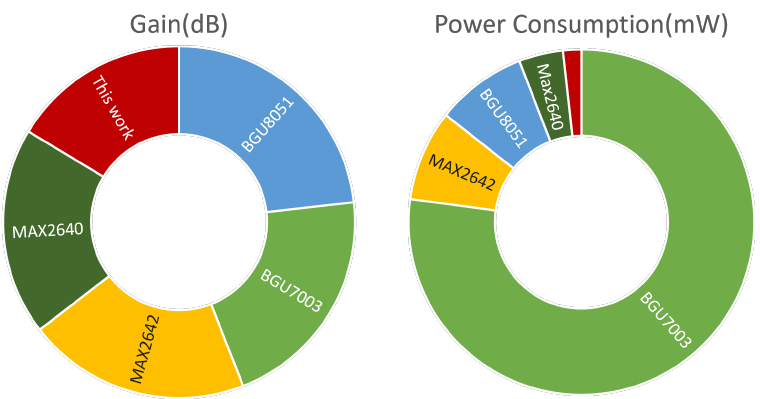
Figure 20. Comparison of gain and power consumption trade-offs in this work with 4 COTS LNA.